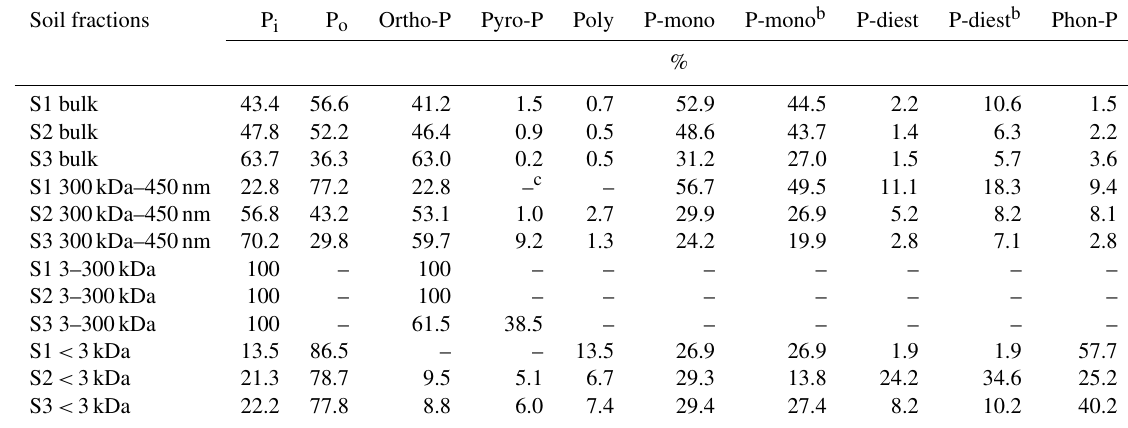
Table 3. The proportion (%) of phosphorus species a determined by solution 31 P-NMR for the different soil fractions of S1 (Cambisol), S2 (Stagnic Cambisol), and S3 (Stagnosol). Soil fractions P i P o Ortho-P Pyro-P Poly P-mono P-mono b P-diest